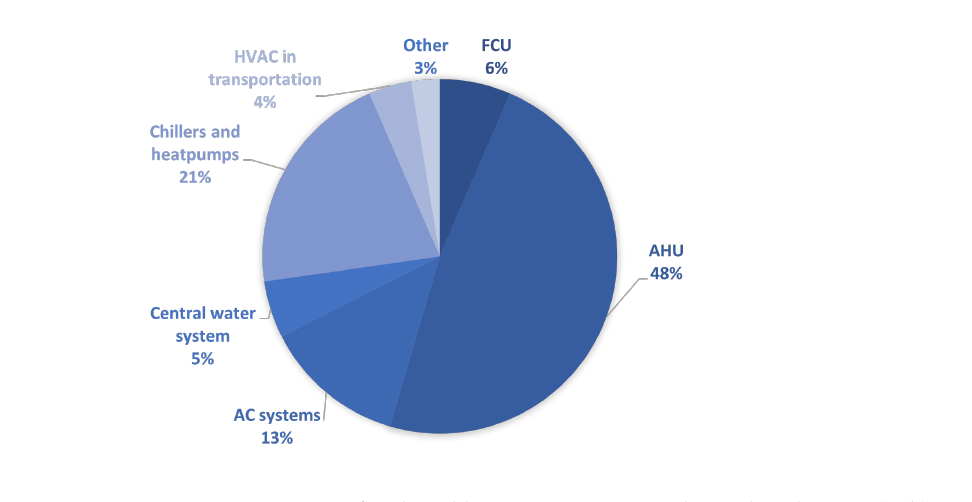
Figure 4. Overview of gathered literature concerning the analyzed HVAC (sub)system type.